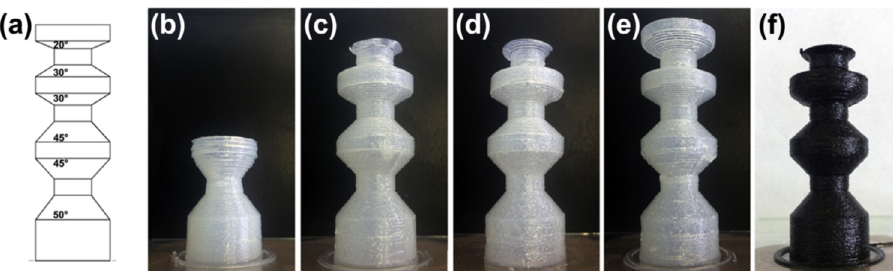
Figure 10. 3D printed models with the inks obtained in [64]. ( a ) Layout of the target model ( b – e ) printed samples with increasing proportion of the photocurable acrylic resin and ( f ) adding carbon fibers. Reproduced from [64] with permission from Elsevier.